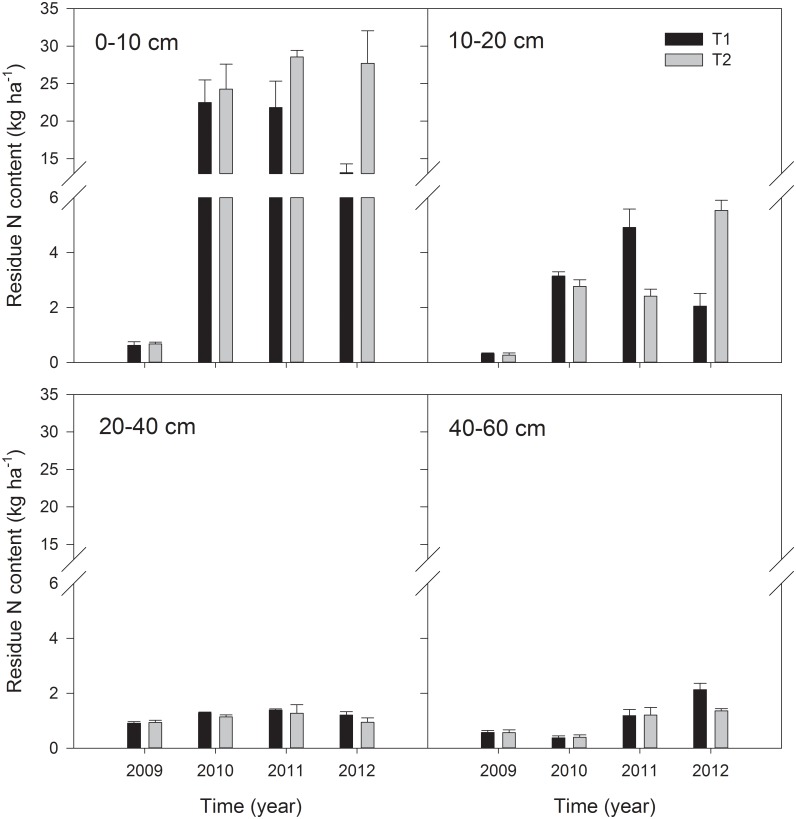
Changes in the residue N content for the four soil layers (0–10, 10–20, 20–40, and 40–60 cm) under different treatments during 2009 to 2012.Error bars indicate standard deviations, n = 3.